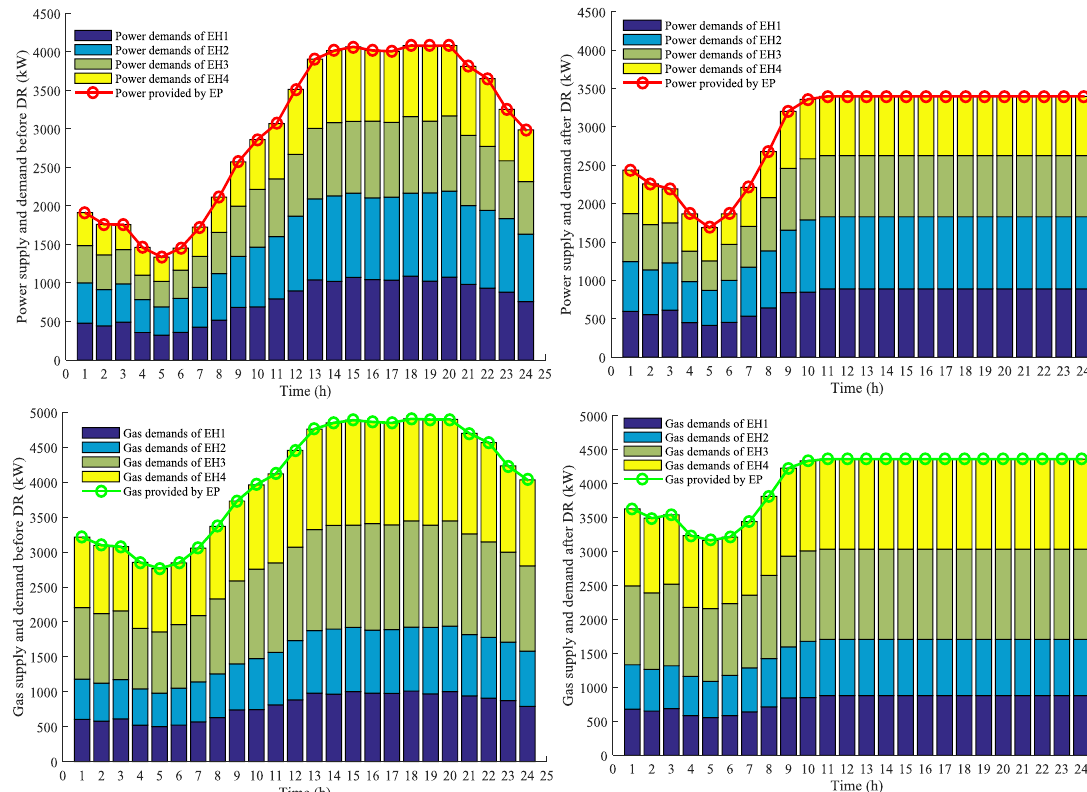
Figure 8. Hourly gas demands of all EHs before and after DR.